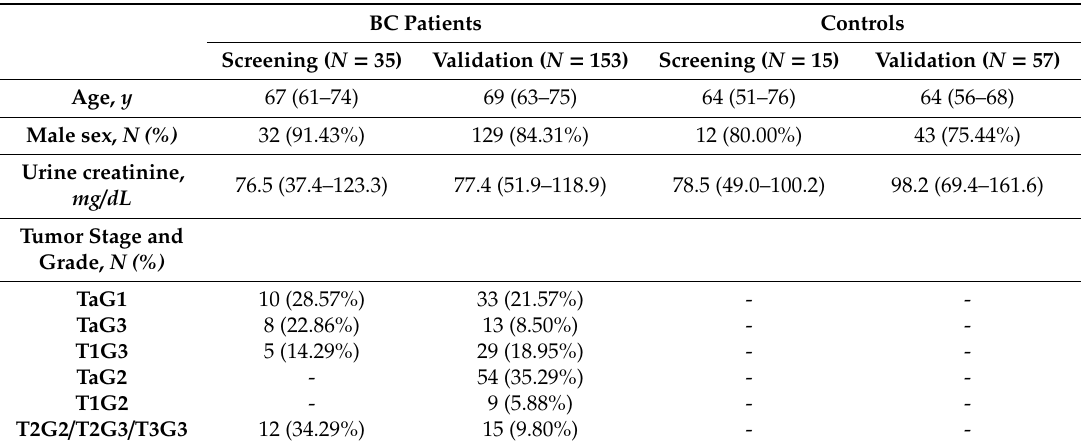
Table 1. Clinical characteristics of the BC patients and healthy controls